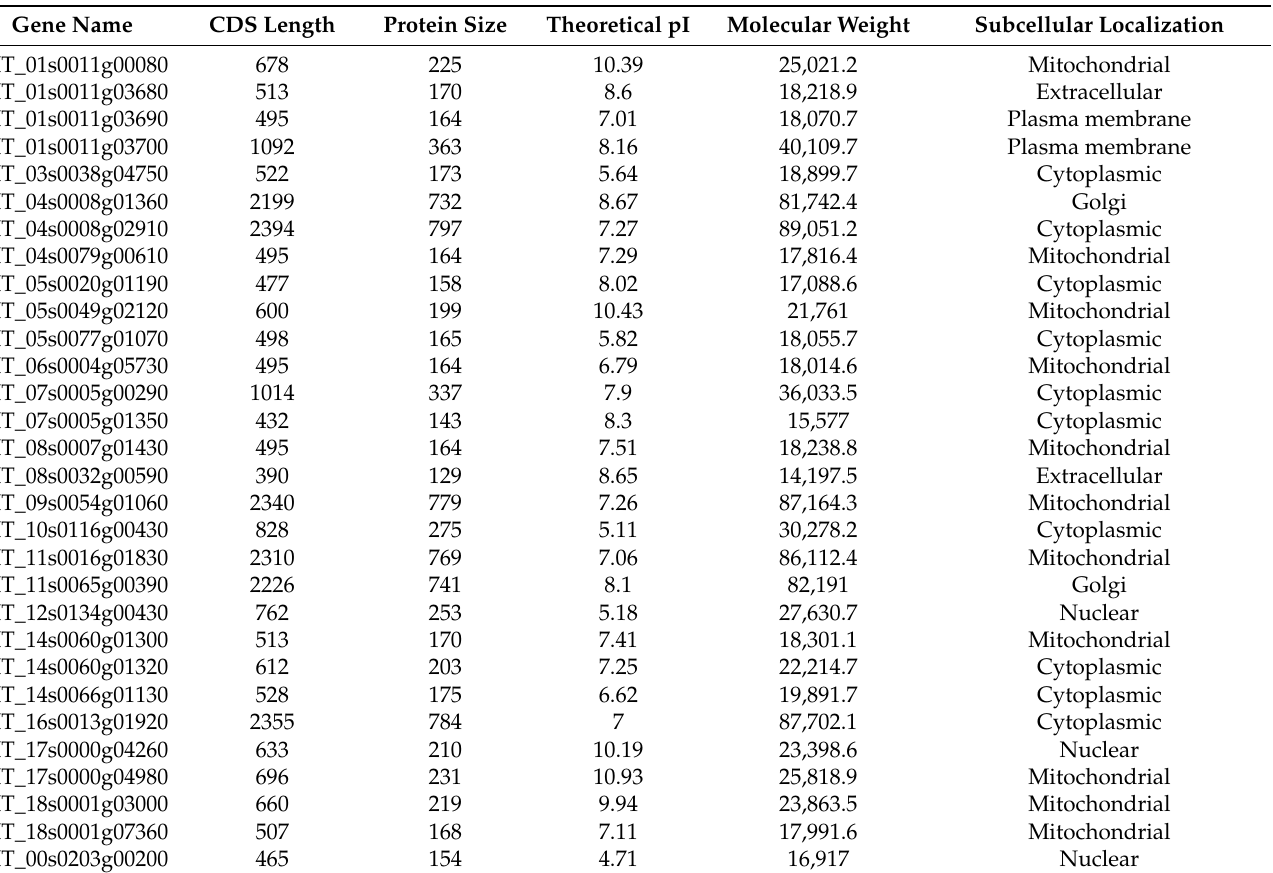
Table 1. Gene ID, CDS length, protein size, and the prediction of theoretical pl, molecular weight and subcellular localization for each VvUSP